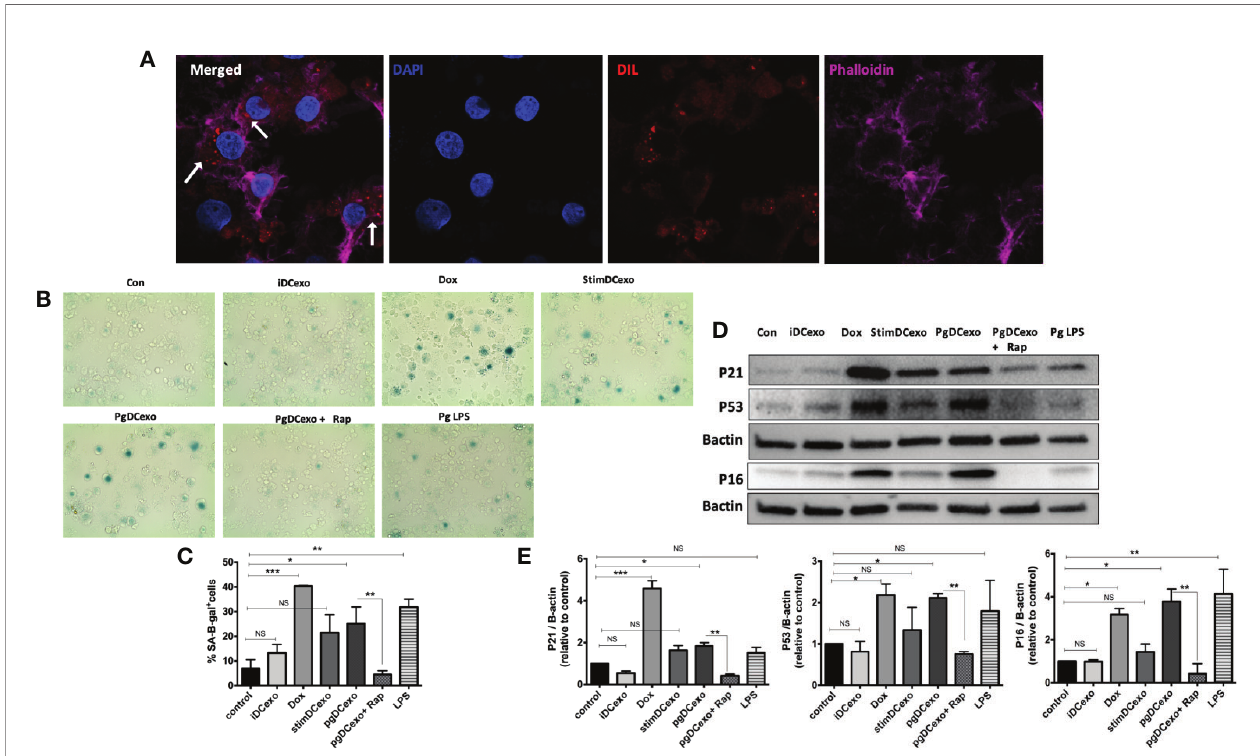
FIGURE 5 | PgDCexo induces paracrine immune senescence in yDCs: (A) Confocal microscopy images showing uptake of Dil-labelled EXO (red) by yDCs with phalloidin actin staining (magenta) and counter stained with blue nuclear stain DAPI (white arrows indicating EXO internalization by yDCs). (B) Representative images of SA- b -gal staining of yDCs treated with PgDCexo ± Rapamycin, Stim DCexo, iDCexo, Dox, Pg LPS or received no treatment (Con) at PH 6, blue stain indicates senescence. (C) Quanti fi cation of % population of SA- b -gal + DCs using FACS analysis. (D) Representative immunoblot image of p16 INK4A , p53, and p21 Waf1/Clip1 expression in yDCs with different treatments. (E) Densitometric analysis of p16 INK4A , p53, and p21 Waf1/Clip1 protein expression in yDCs with different treatments. b - actin was used as a loading control. Band densities were normalized to b -actin, and data presented as fold change relative to the control. Analysis was done using one-way ANOVA and Tukey multiple comparison post hoc test (Data are expressed as means ± SD, *p<0.05, **p<0.001, ***p<0.0001). (iDCs), control immature DCs exo; (StimDCexo), Ecoli LPS-stimulated mature DCs exo; (PgDCexo), Pg-infected DCs. NS, not signi fi